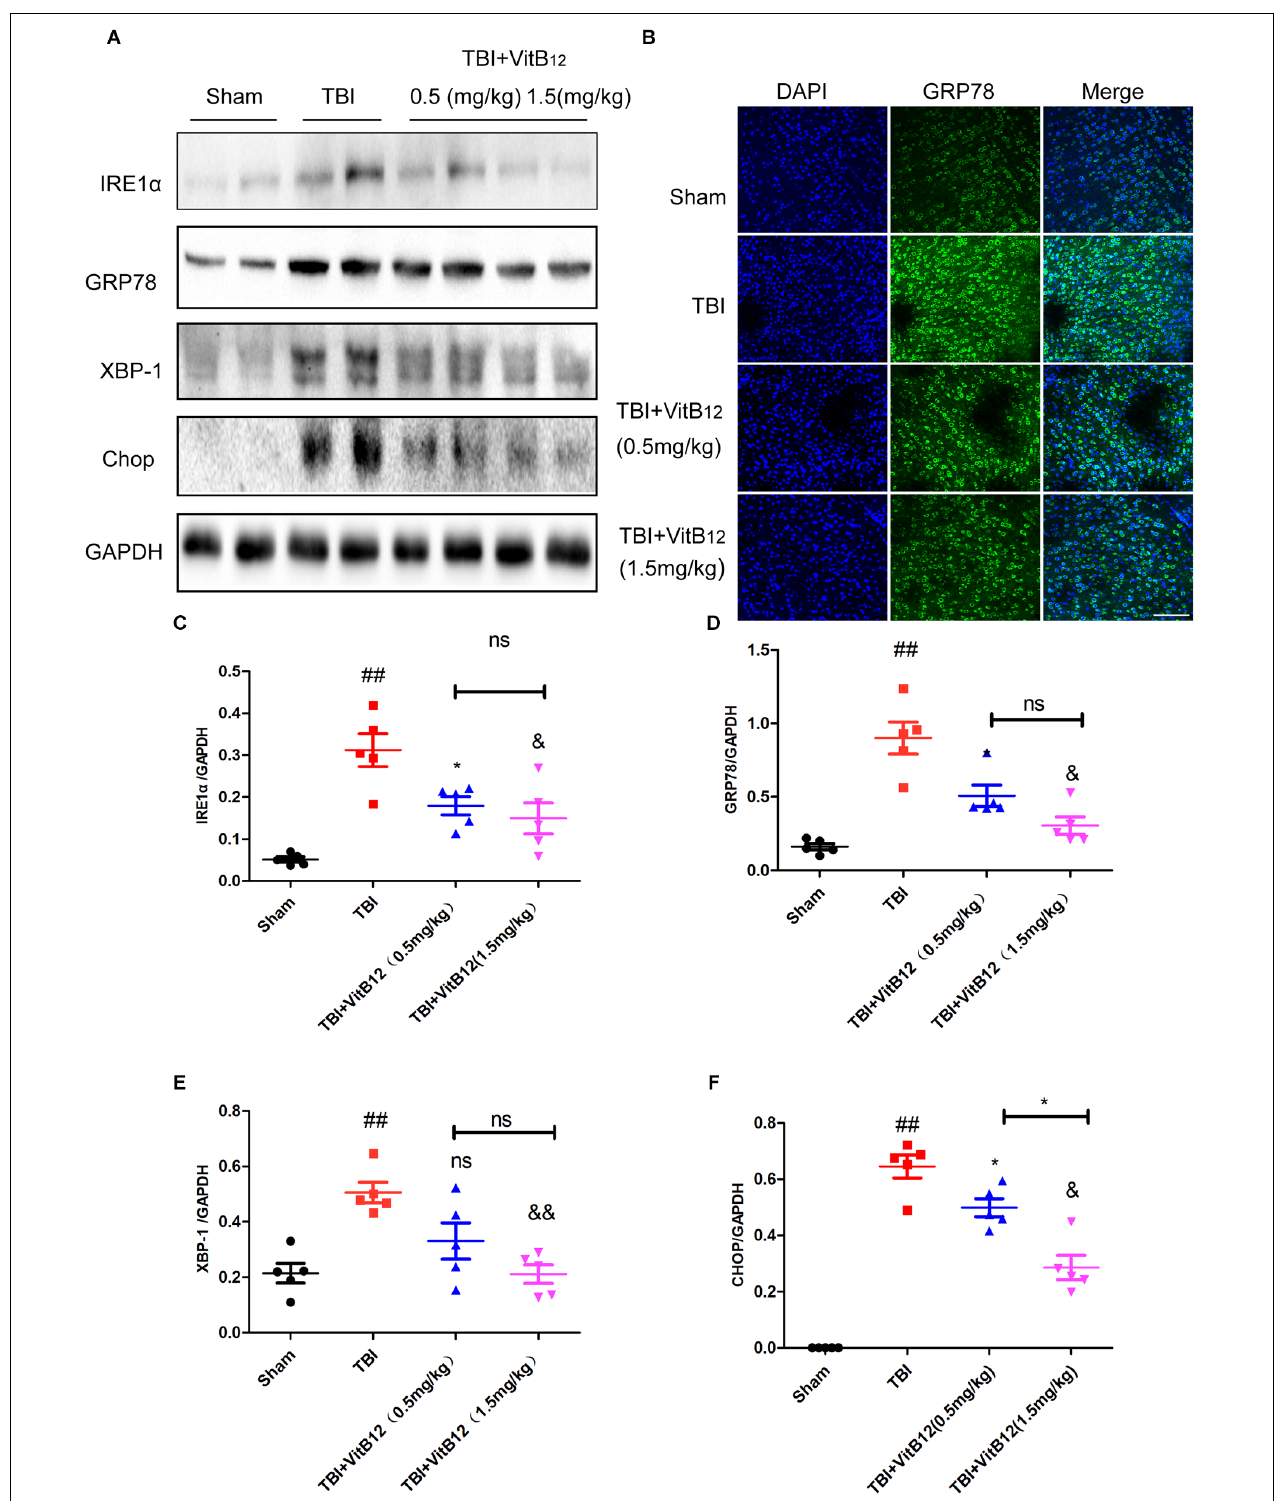
FIGURE 3 | Vitamin B12 reduces the level of ER stress. (A) Representative western blots of the expression of IRE1 α , GRP78, XBP-1, Chop. (B) Immunofluorescence staining of GRP78 (green) in the cortex at 7 days post-injury. Scale bar = 100 µ m. (C–F) Quantification from (A) ## P < 0.01 vs. the sham group. ∗ P < 0.05, & P < 0.05, and && P < 0.01 vs. the TBI group. ∗ P < 0.05 vs. the indicated group. Values represent the mean ± SEM, n =